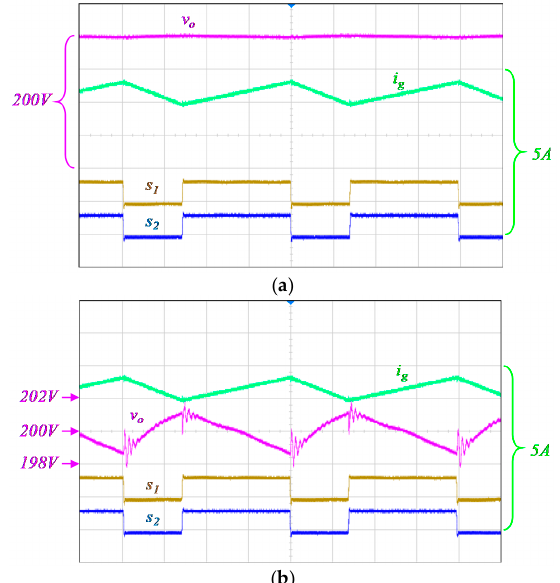
Figure 13. ( a ) The output voltage, input current, and firing signals when D = 0.6476 ( Vg ≈ 25 V) in the former strategy and ( b ) same signals with a zoom in the output voltage ripple.